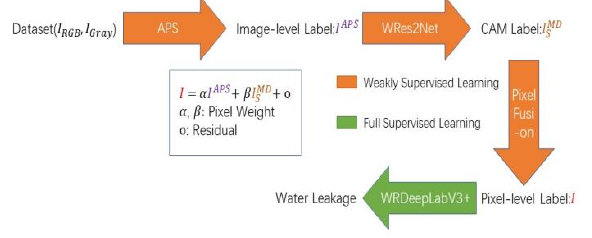
Figure 2. Basic idea of